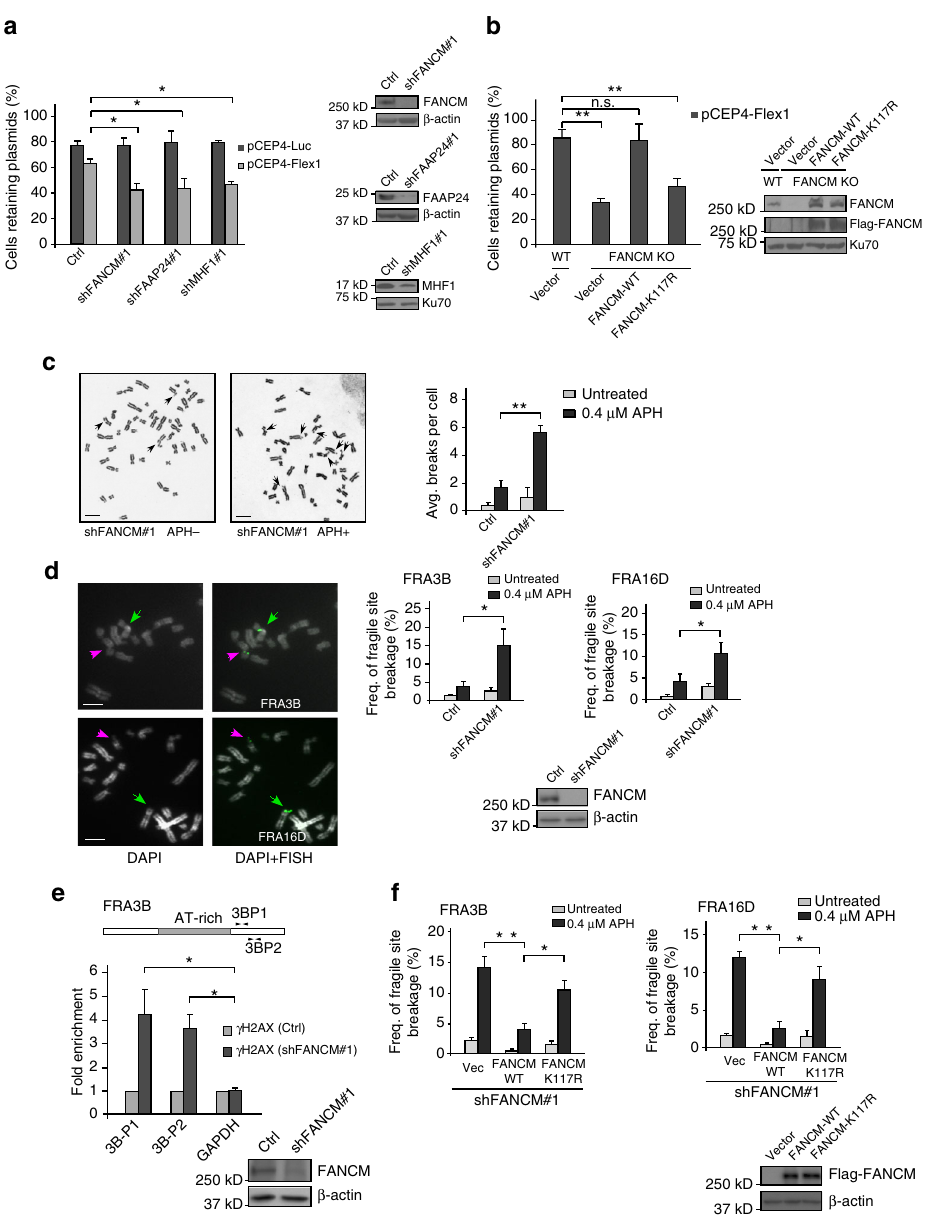
Fig. 3 FANCM translocase activity is important for CFS protection. a , b Plasmid stability assay was performed in cells carrying pCEP4-Flex1 or pCEP4-Luc plasmids after culturing cells without hygromycin for 1 week. U2OS cells expressing indicated shRNAs or control vector ( a ), and HCT116 WT or FANCM KO cells reconstituted with Flag-FANCM (WT or K117R) ( b ) were used. c Metaphase spread of HCT116 cells was performed with or without expressing FANCM shRNA or vector before and after APH treatment (0.4 μ M, 24 h). Representative images of metaphase spread are shown on the left, and overall chromosome gaps and breaks per cell are shown on the right. d FISH images of HCT116 cells after DAPI staining using probes against FRA3B or FRA16D are shown (left). Purple and green arrows indicate broken and normal chromosomes, respectively. Frequency of CFS expression at FRA3B or FRA16D in HCT116 cells expressing FANCM shRNA or control vector before and after APH treatment was determined (right). FANCM expression is shown by western blots. e Anti- γ H2AX ChIP analysis at FRA3B locus using primer sets 3B-P1 and 3B-P2 was performed in U2OS cells expressing FANCM shRNA or vector before and after APH treatment (0.4 μ M, 24 h). ChIP value in Ctrl is set up as 1 for normalization. f Frequency of CFS expression at FRA3B or FRA16D in HCT116 cells expressing Flag-FANCM (WT or K117R) with endogenous FANCM silenced before and after APH treatment (0.4 μ M, 24 h) was determined. Expression of indicated Flag-FANCM alleles is shown by western blots. Bars, 5 μ cells. Normal forks can be regenerated and restarted upon fork restoration.